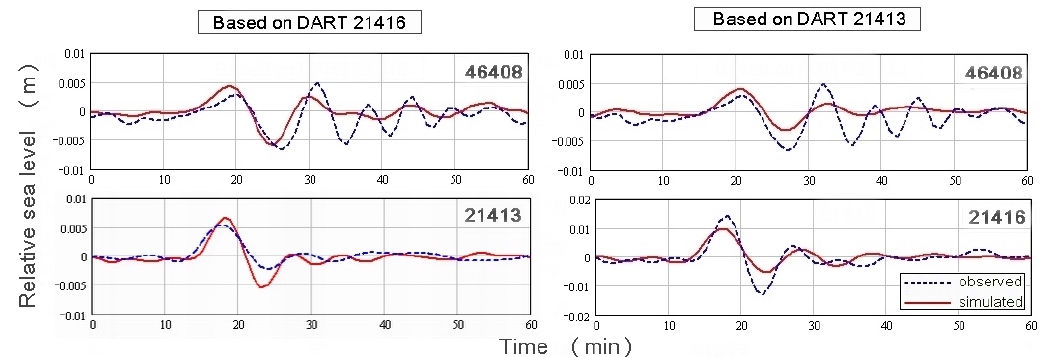
Fig. 7. The same as in Fig. 5 but for the 2009 Simushir tsunami. Left column is for DART 21416 as the reference station; right column is for DART 21413 as the reference